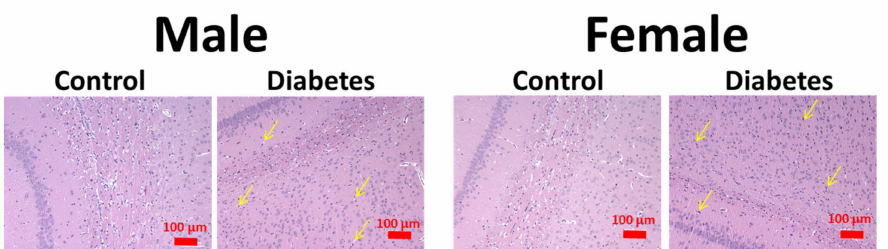
Figure 4. Representative hematoxylin and eosin staining of rat cortexes of different groups. Yellow arrows indicate damaged